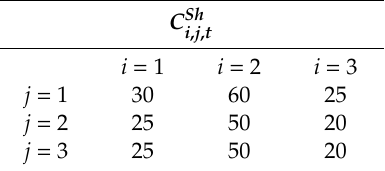
Table A14. Unit backorder penalty cost ( € ) (considered here the same for any t ).